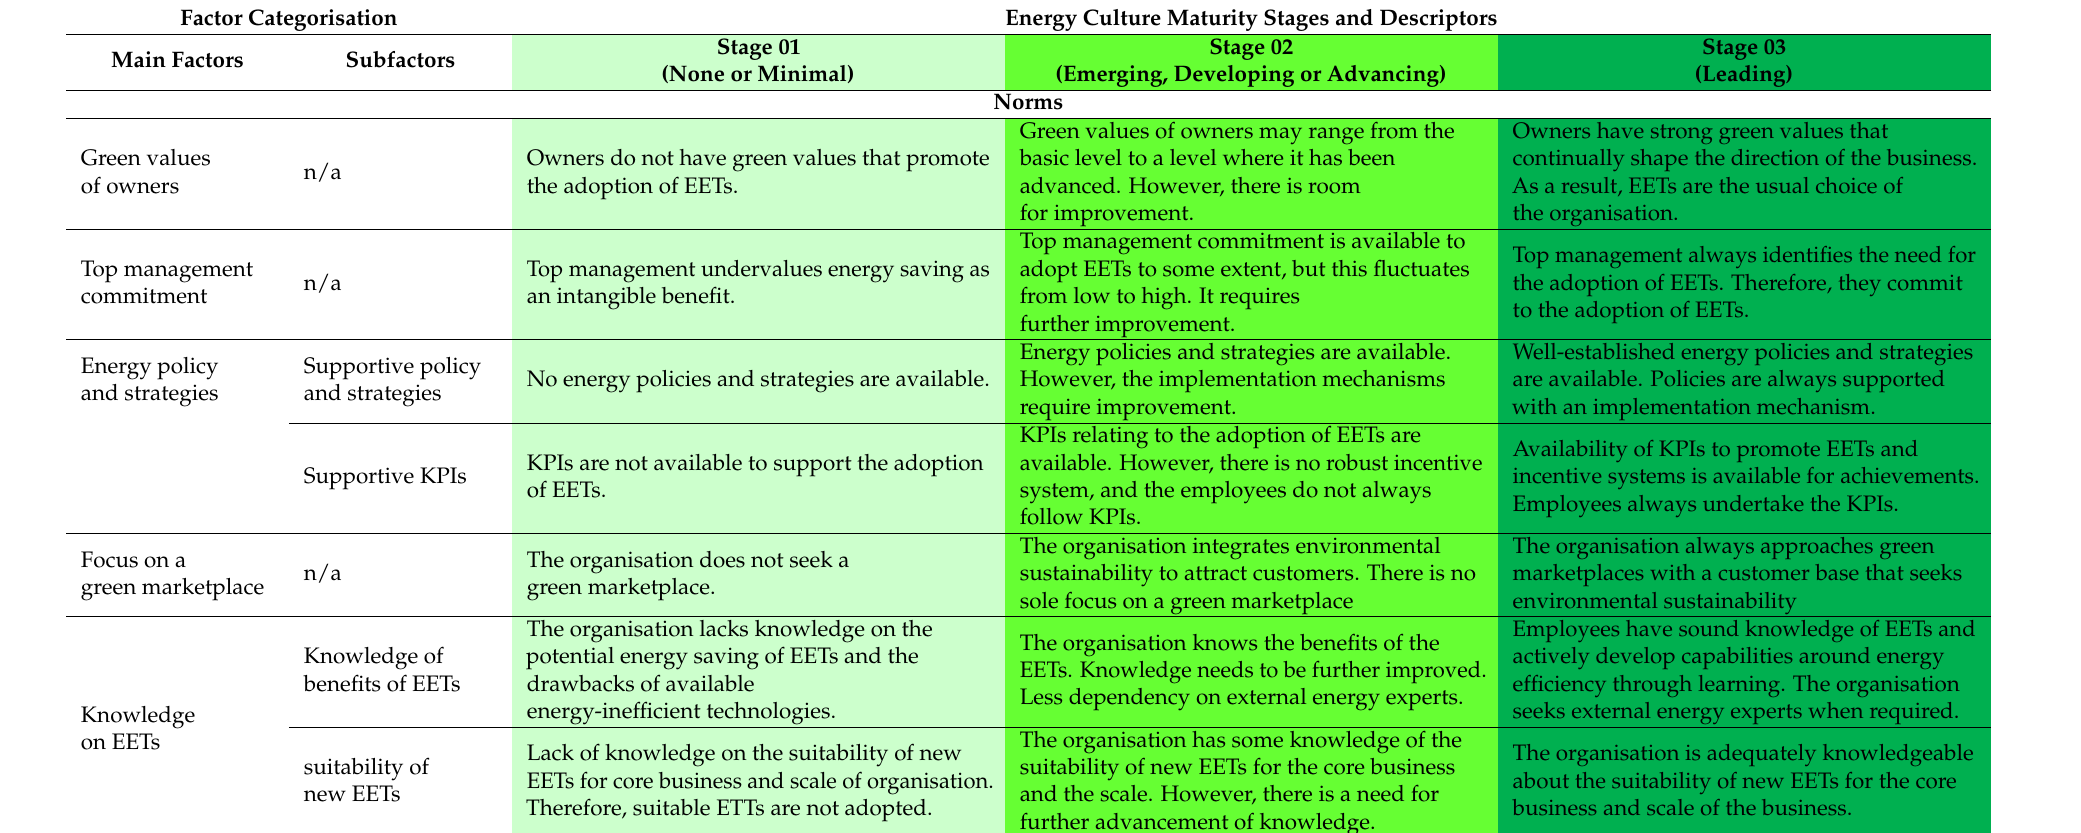
Table 6. Factors and maturity stage descriptors of the